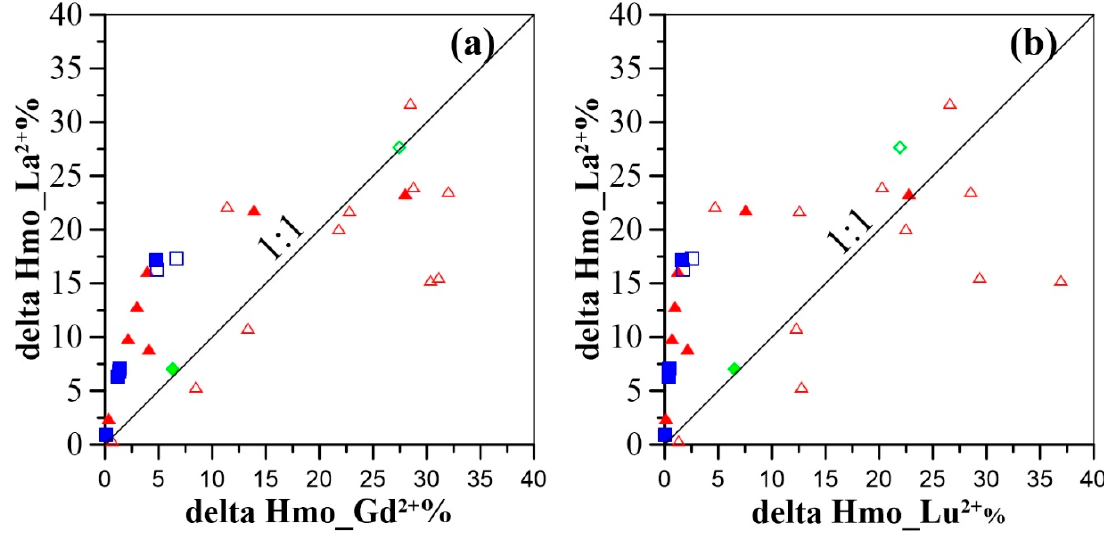
Figure 10. Delta fractions of Hmo_La 2 + as a function of delta fractions of Hmo_Gd 2 + (a), and Hmo_Lu 2 + (b) (delta REE-HMO fractions were obtained by decreasing 50% of the dissolved Mn invoked in the model (Ln% sorbed Total Mn —Ln% sorbed 50% Mn ). It should be noted that those groundwater samples with Mn concentrations less than 0.1 µ mol / L were not considered).